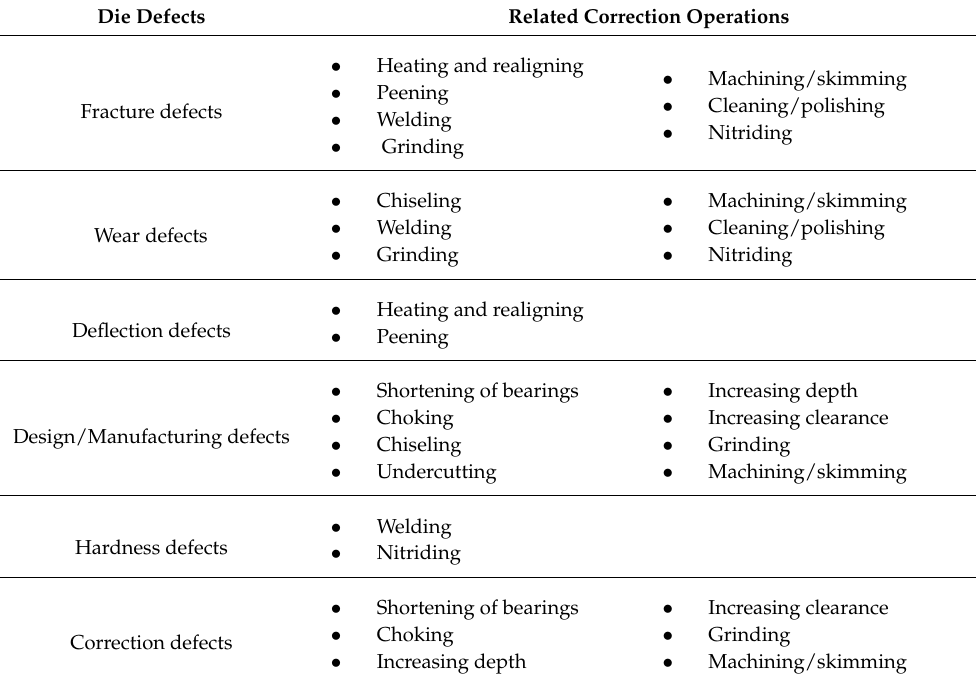
Table 4. Major correctable die defects and related correction